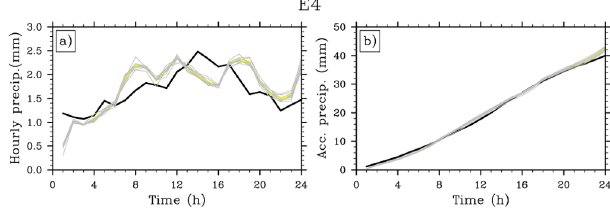
Fig. 9. As Fig. 8 but for the ensemble E4 (C´evennes